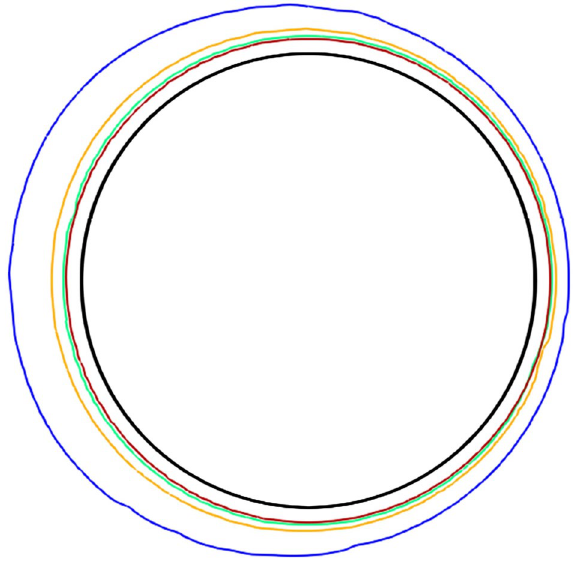
Figure 10. Contour lines of precipitated solid phase (blue: sphere 1, orange: sphere 2, green: sphere 3, red: sphere 4) on spherical particles at 200 h ( t ∗ = 25,200). Black line represents the initial shape of the sphere.